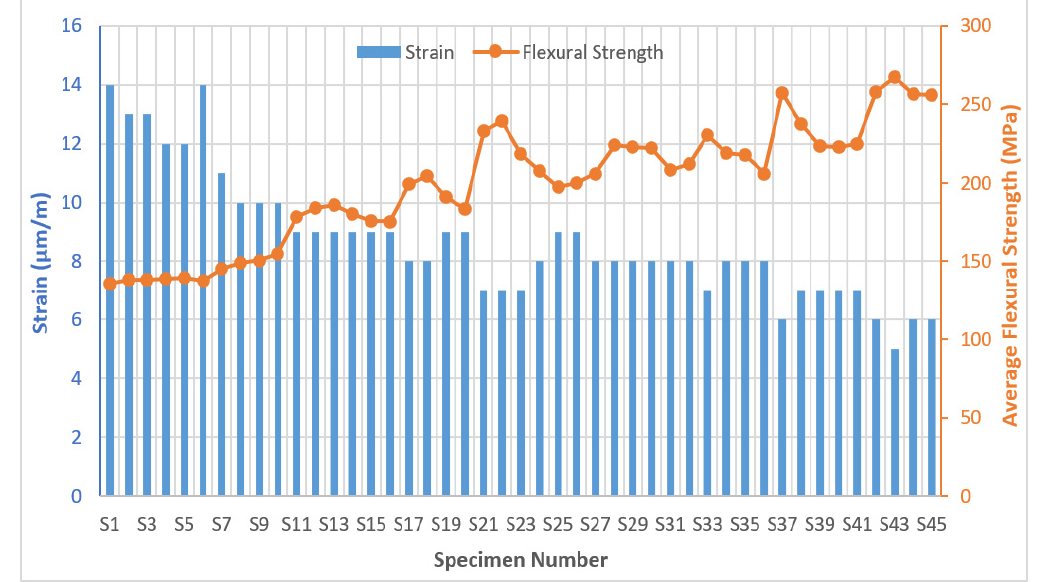
Figure 9. Correlation between strain measurements and flexural strength.